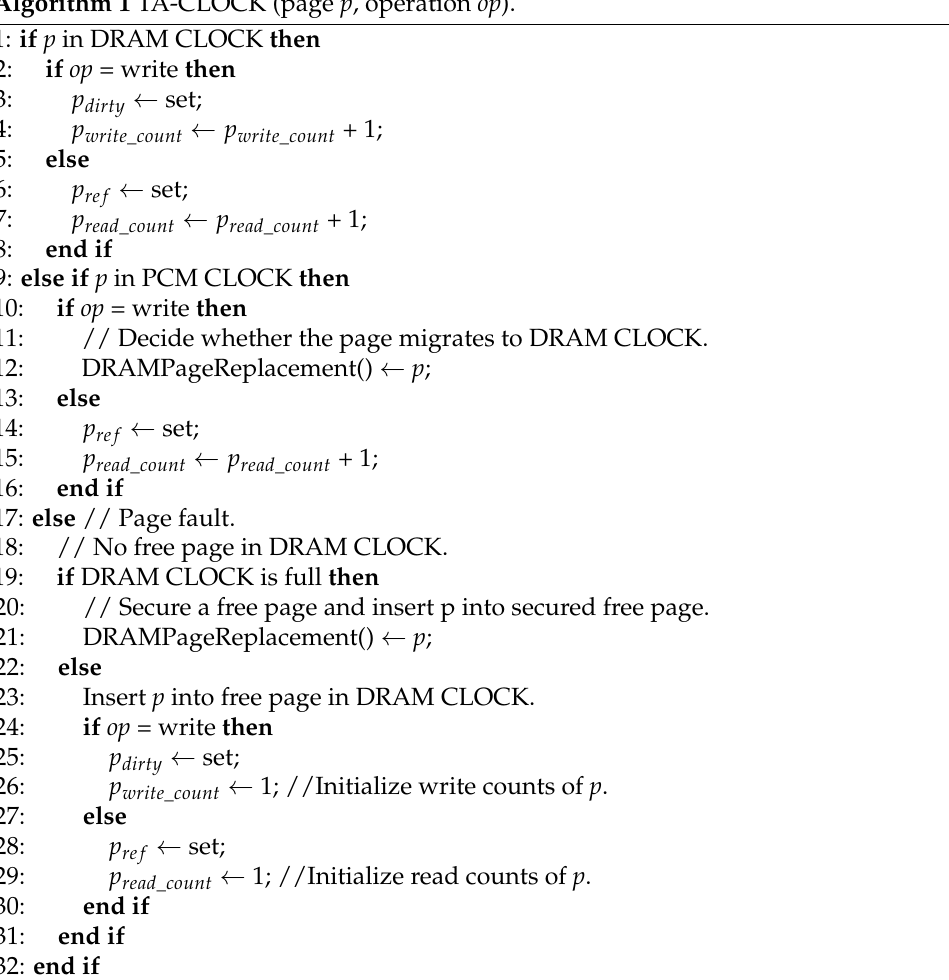
Algorithm 1 TA-CLOCK (page p , operation op